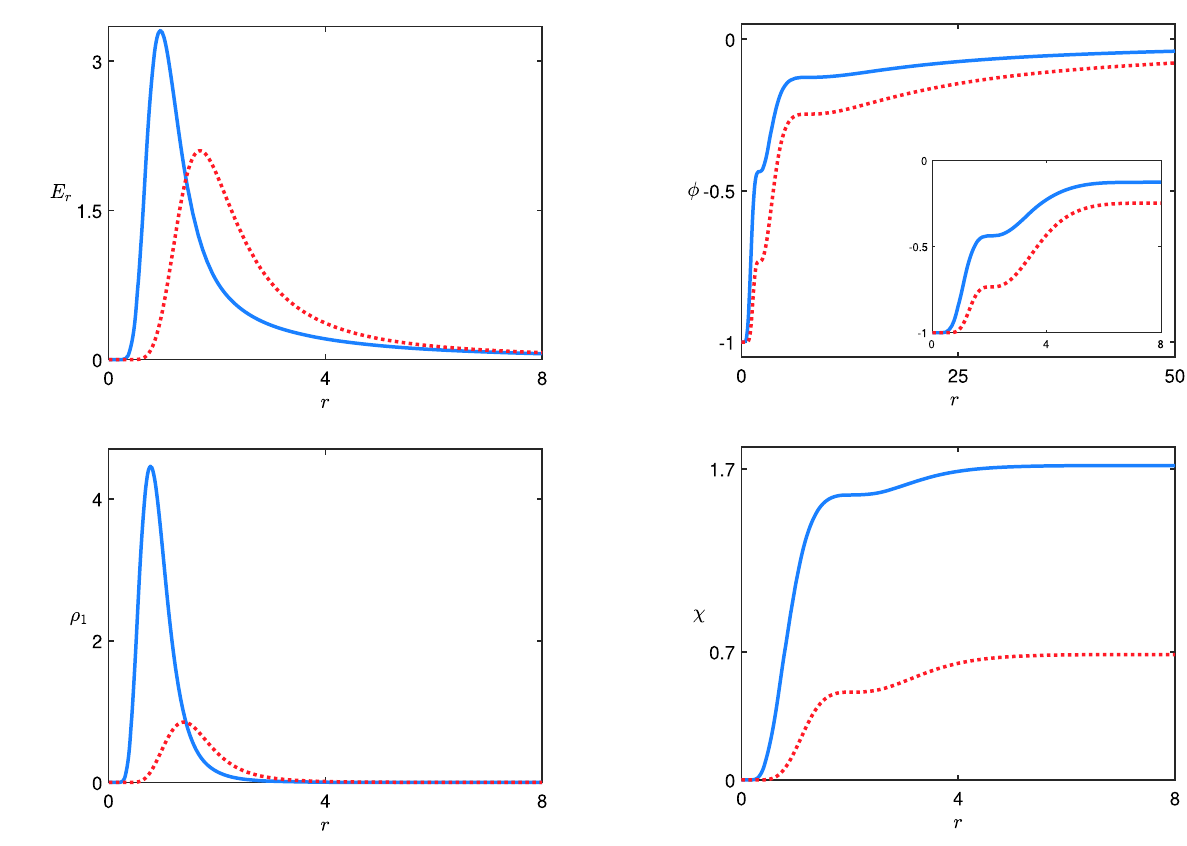
Fig. 18 The solutions φ( r ) (top) and χ( r ) (bottom) associated to the model in Sect. 4.2.2 for σ = 5, α = 2 and n = 2 with k = 1 (solid, blue line) and 2 (dotted, red line). The inset in the top figure shows the behavior for small